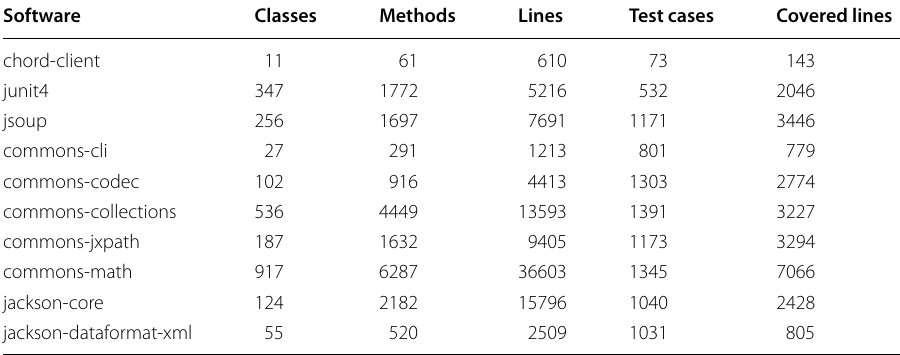
Table 2 Sizes of the software systems (number of classes, methods and lines of code) and the related test